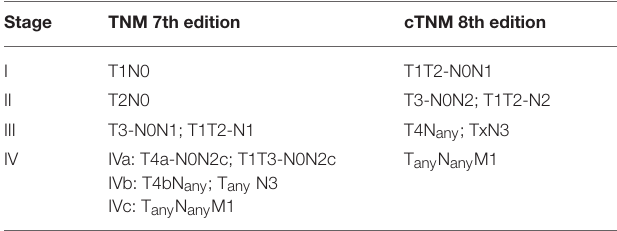
TABLE 1 | Differences in clinical group staging between the 7th and 8th edition AJCC/UICC TNM classification system (cTNM) for Human Papillomavirus related oropharyngeal squamous cell